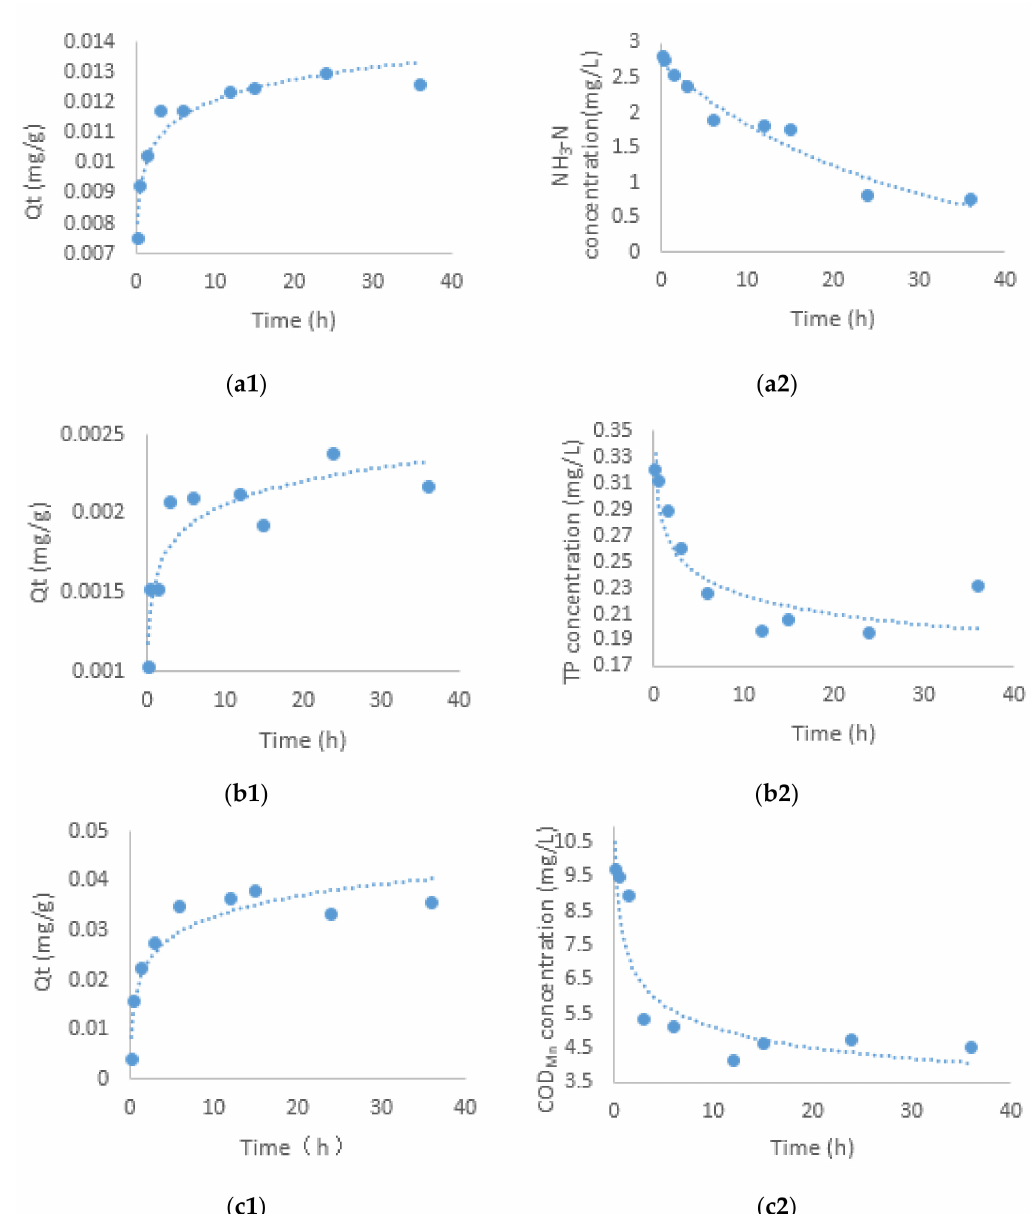
Figure 5. The adsorption amount or concentration change trend of various pollutants ( a1 , a2 : NH 3 -N, b1 , b2 : TP, c1 , c2 : COD Mn ) in batch